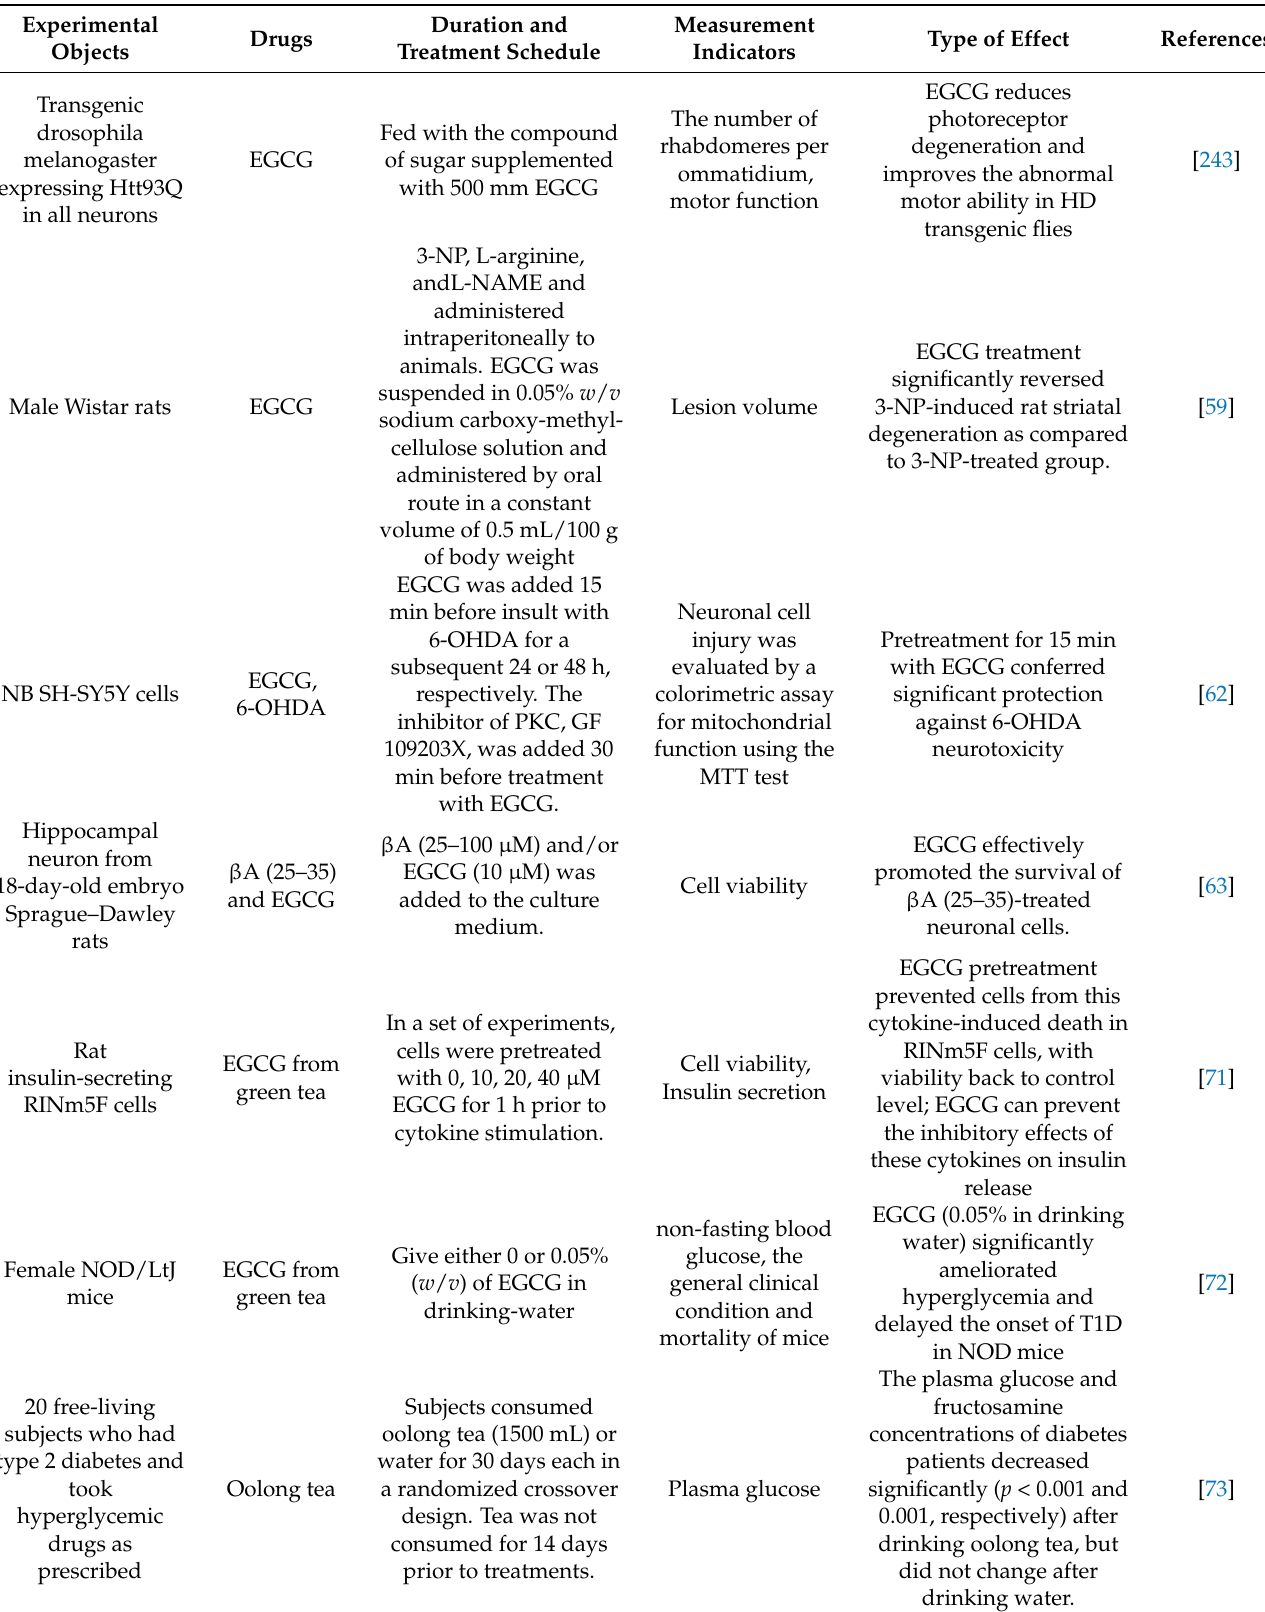
Table 1. Possible mechanisms of catechins’ protective action in neurodegenerative diseases demon- strated in various disease